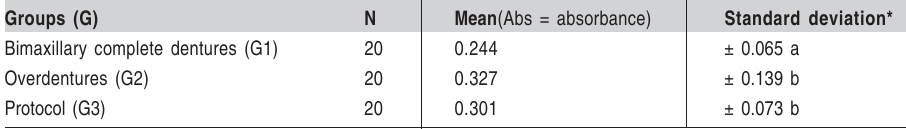
Table 1 - Data for masticatory